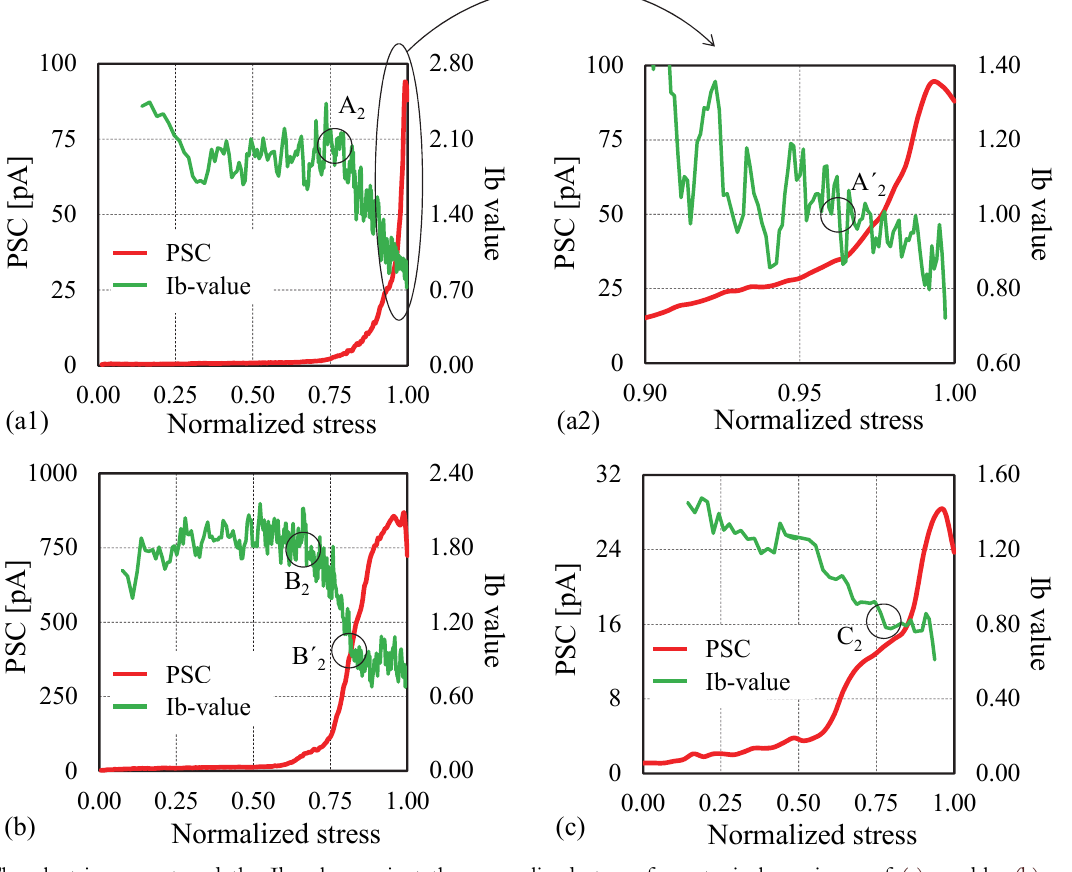
Figure 4: The electric current and the Ib-value against the normalized stress for a typical specimen of (a) marble, (b) mortar and (c)